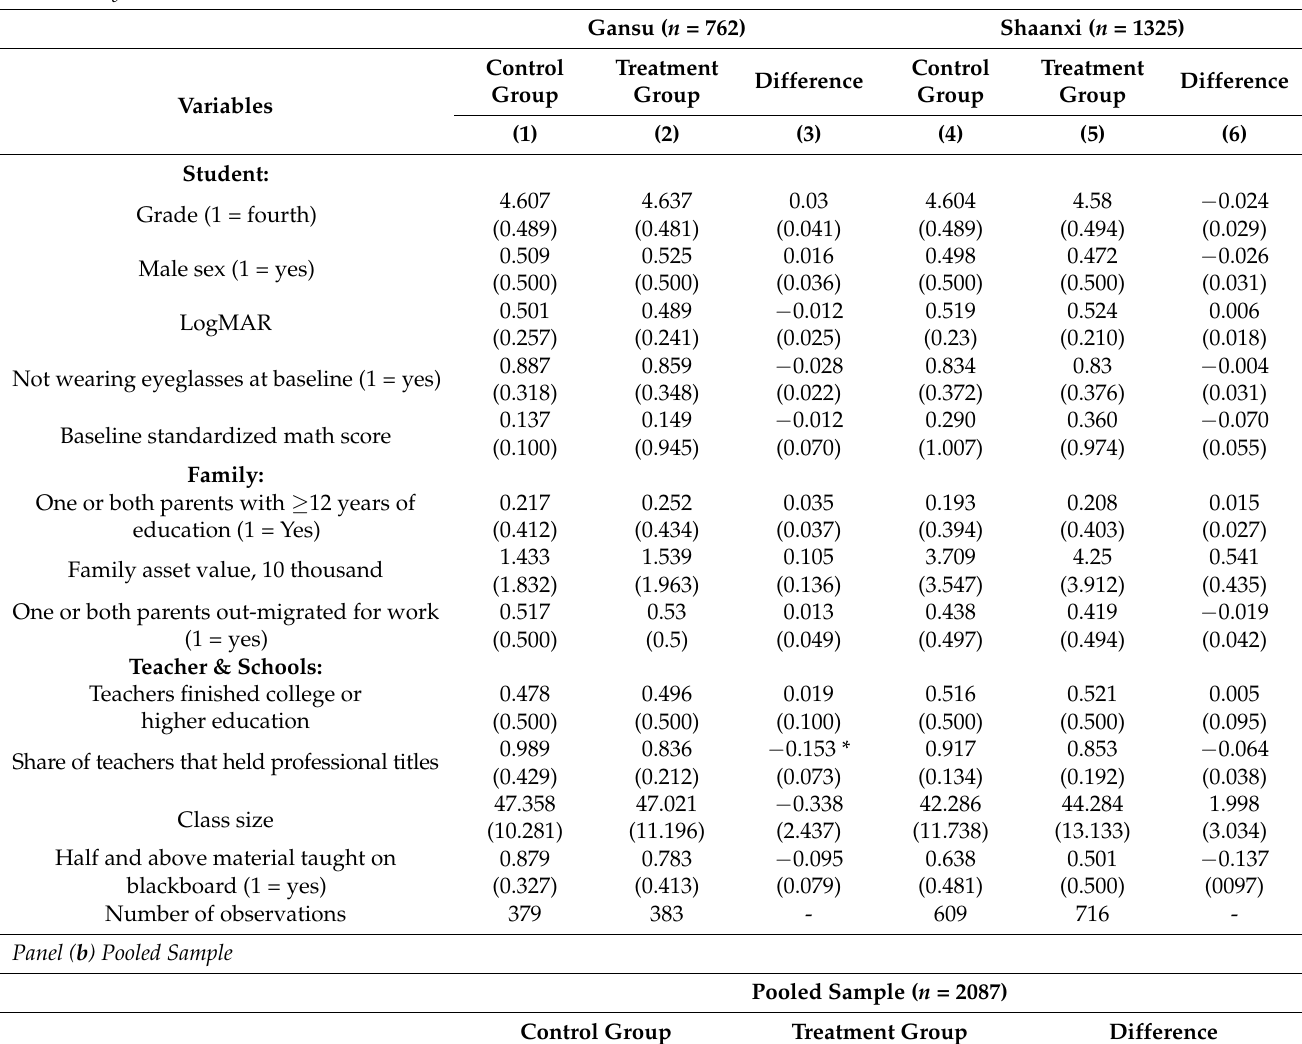
Table 1. ( a ) Baseline characteristics difference between treatment and control groups by province. ( b ) Baseline characteristics difference between treatment and control groups using pooled